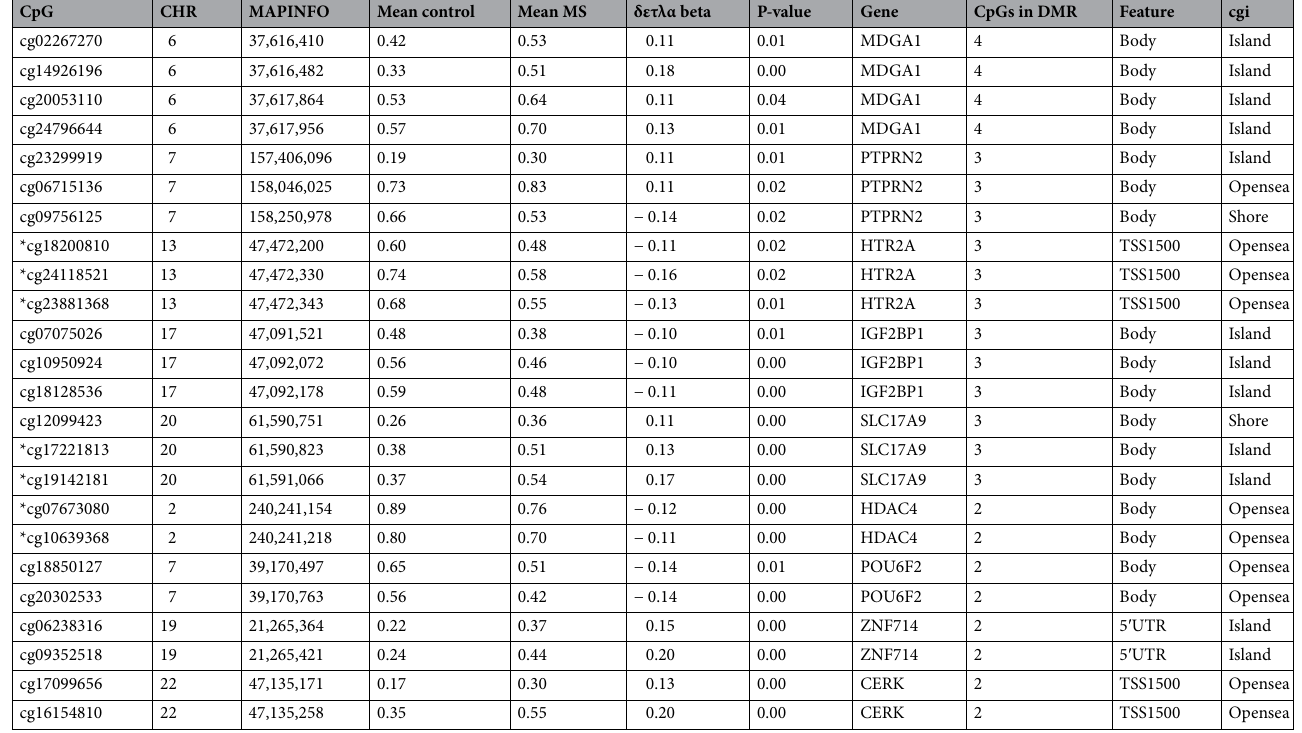
Table 2. DMRs in discovery